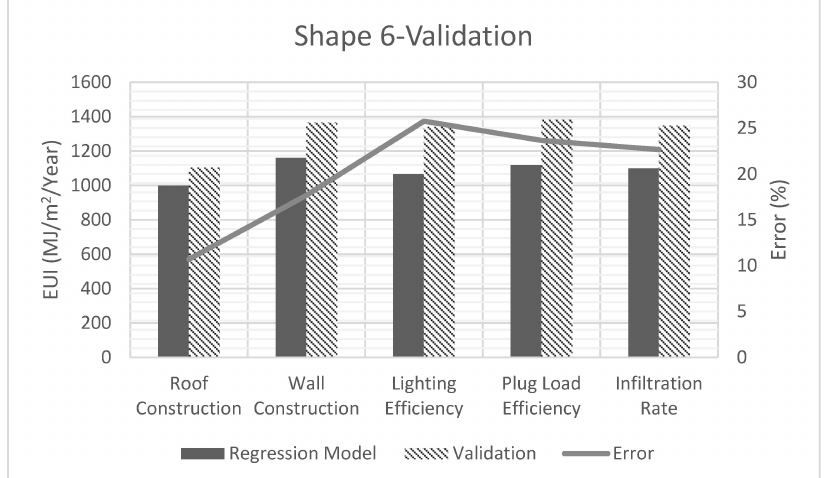
Figure 25. TETB Shape 6